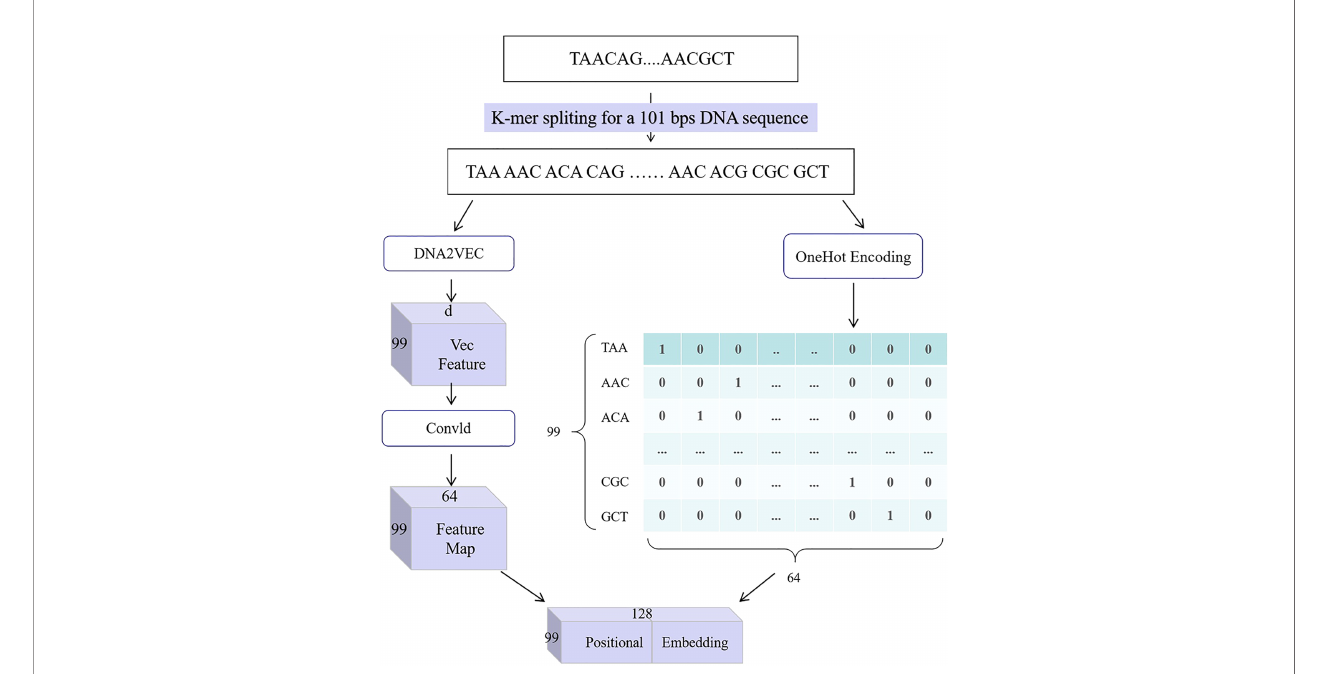
FIGURE 2 | DNA positional embedding for an original DNA sequence with 101-bps length and 3-mer